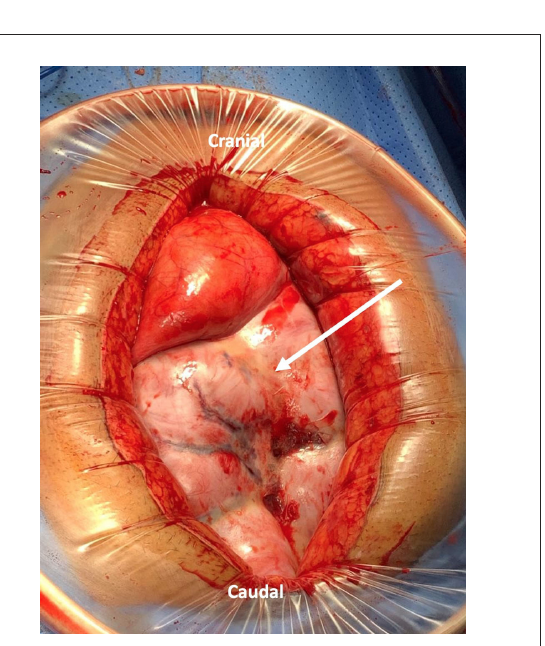
FIGURE2 Laparotomy incision showing a thick fibrous membrane encasing the small bowel resembling a cocoon (Arrow indicates the sac).